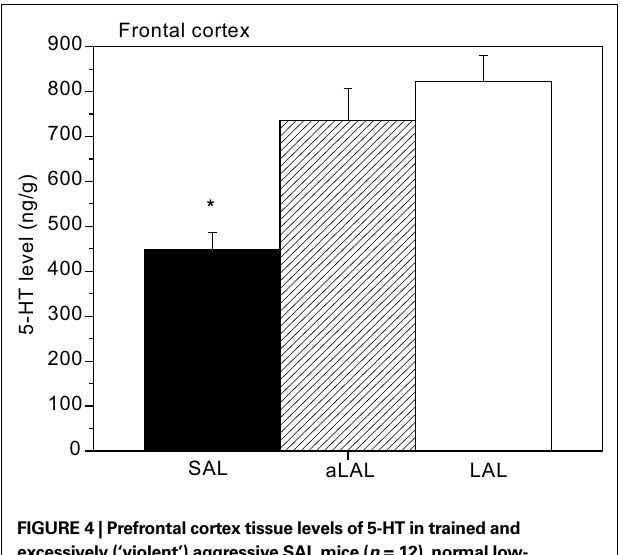
FIGURE 4 | Prefrontal cortex tissue levels of 5-HT in trained and excessively (‘violent’) aggressive SAL mice ( n = 12), normal low- aggressive LAL ( n = 8) and non-aggressive LAL mice ( n = 11). * indicates signifi cant different ( p < 0.05; student t -test) from the (a)LAL